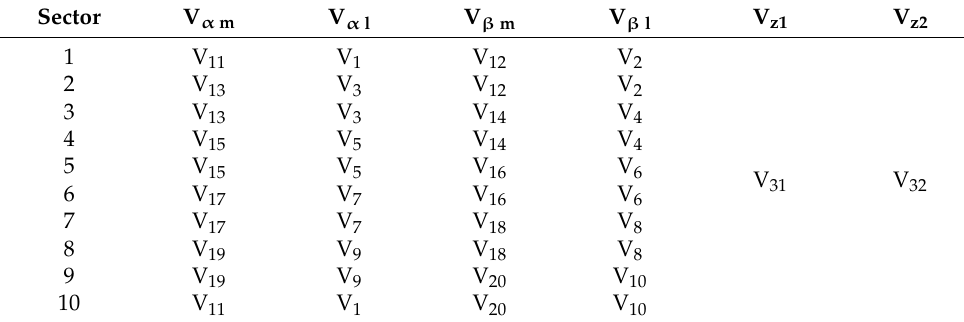
Figure 6. Process of the vector times encoding for the output rectifier to the PWMs. Table 3. The layout of the inverter vectors according to the sector.